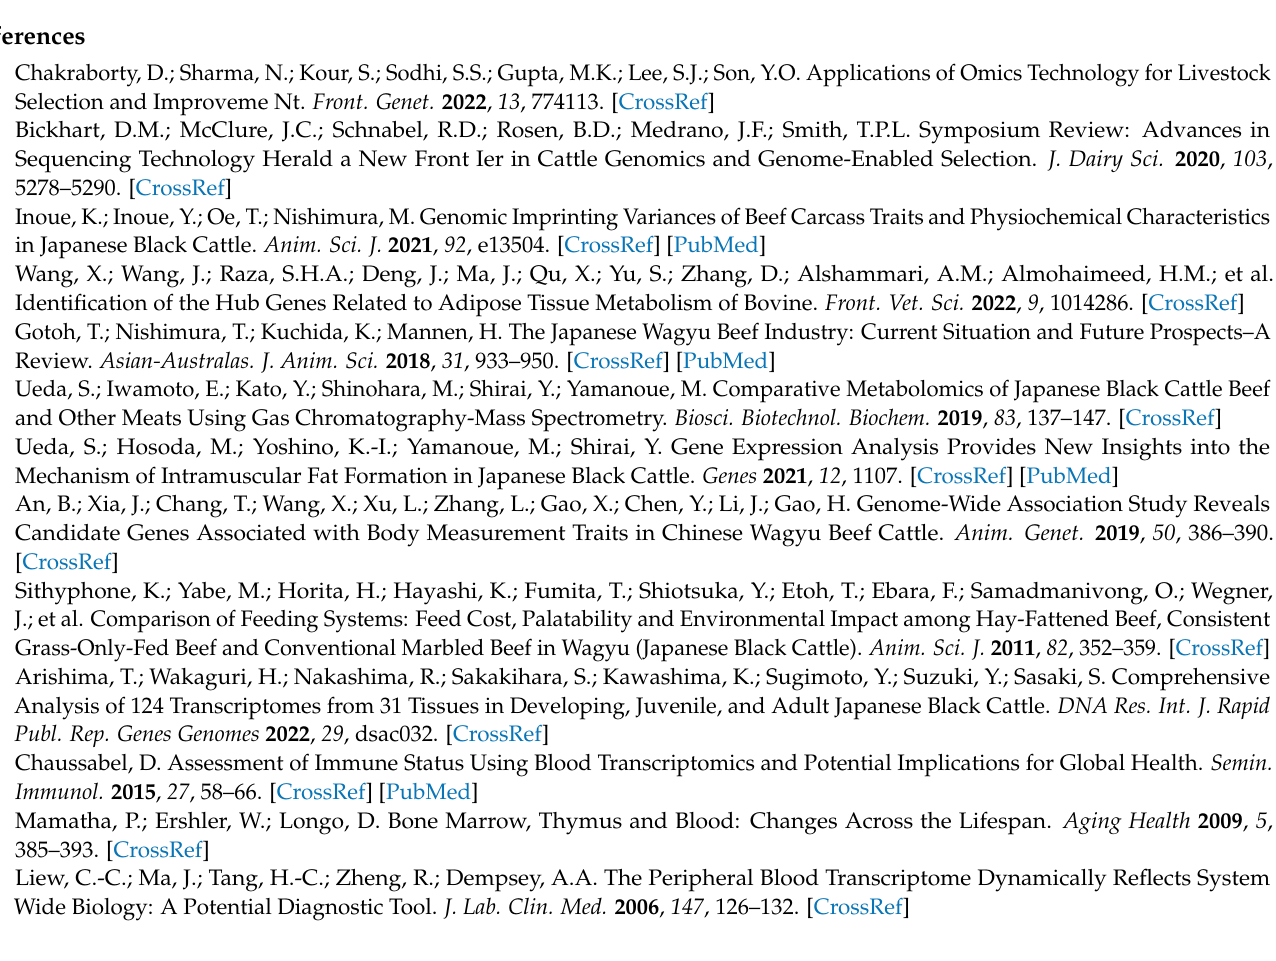
old; Table S6: GO enrichment for specific modules; Table S7: KEGG enrichment for specific modules; Table S8: Number of EWSS mapped genes in different